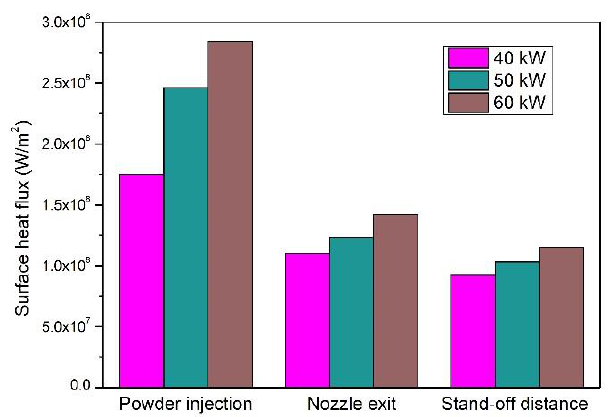
Figure 7. Surface heat flux transferred from plasma gas to particles at different positions along the torch axis for different net torch powers. 40 SLPM of argon, 8 SLPM of hydrogen, chamber pressure: 100 Pa.